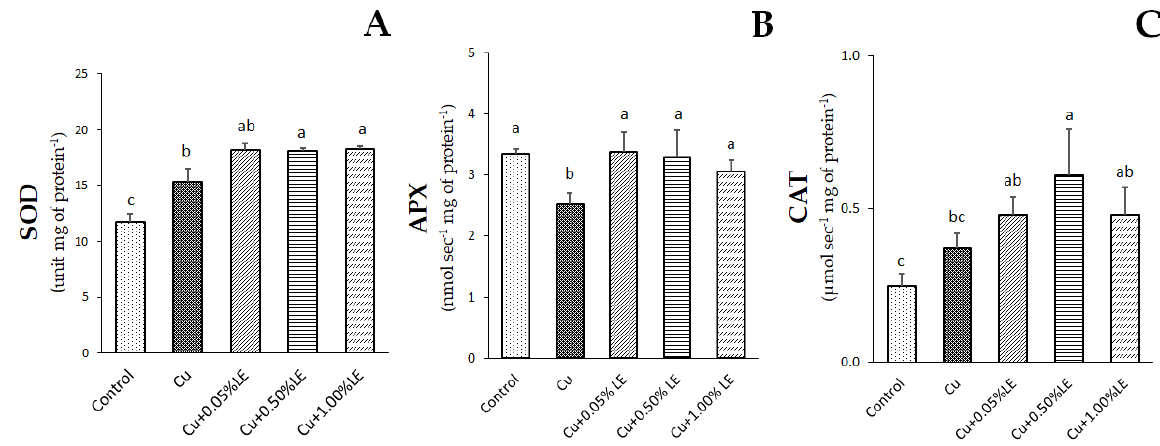
Figure 2. Superoxide dismutase (SOD— A ), ascorbate peroxidase (APX— B ) and catalase (CAT— C ) activity recorded in control maize, samples treated with Cu alone and in combination with 0.05%, 0.50% and 1.00% LE. Bars indicate standard deviations (SD). Values with different letters were significantly different ( p < 0.05), as indicated by the one-way ANOVA followed by Duncan’s new multiple range test.